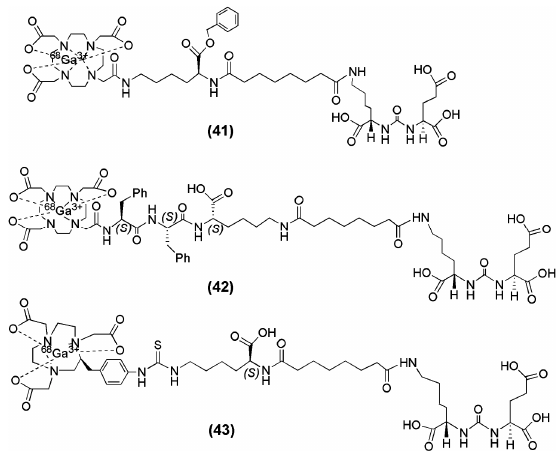
Figure 12. Chemical structures of the two DOTA- ( 41 and 42 ) and the NOTA-conjugated ( 43 ) PSMA inhibitors labeled with 68 Ga [131,132].